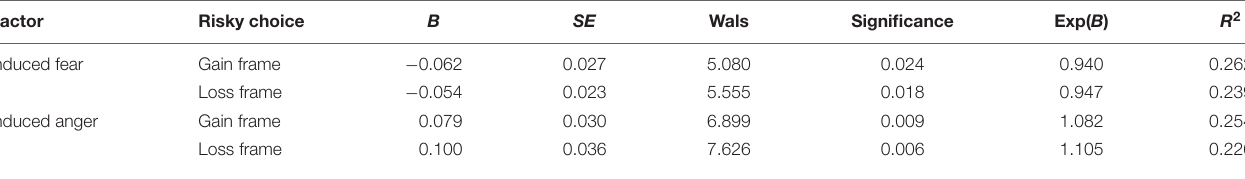
TABLE 5 | Logistic regression of choices on induced emotion strength.